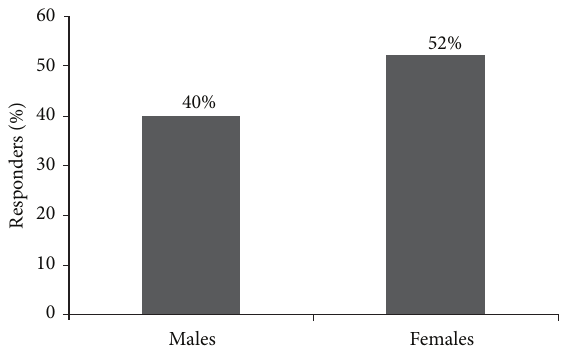
Figure 2: Percent of males and females that know all of the objectives of VAERS (data not controlled for age) ( 𝜒 2 = 4.2 , 𝑃 = .041